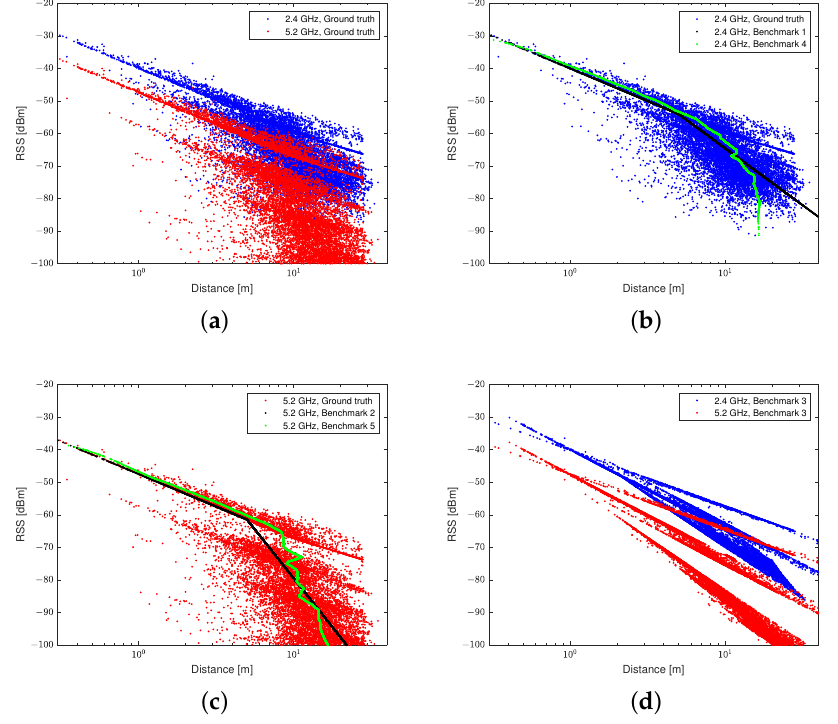
Figure 8. ( a ) Distance–RSS data of the ground truth, and the regression results of the ( b ) 2.4 GHz, ( c ) 5.2 GHz, and ( d ) dual-band